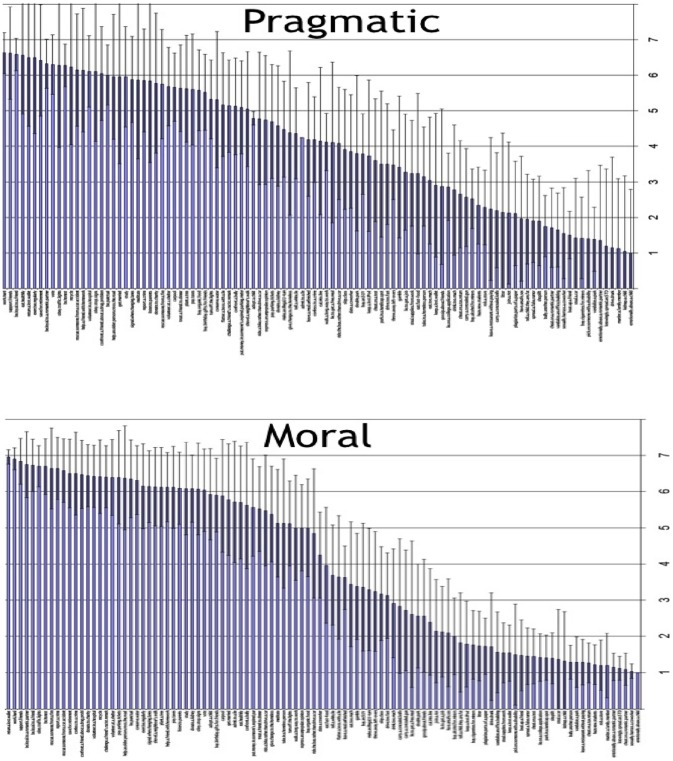
The mean pragmatic and moral ratings (with standard errors) for each action in Experiment 1.The actions have been rank ordered on the Y-axis from the highest (left) to lowest (right) mean rating. The X-axis reflects the rating scale (range 1–7). Pragmatic ratings are relatively linear whereas moral ratings are curvilinear, reflecting differences in extremity.